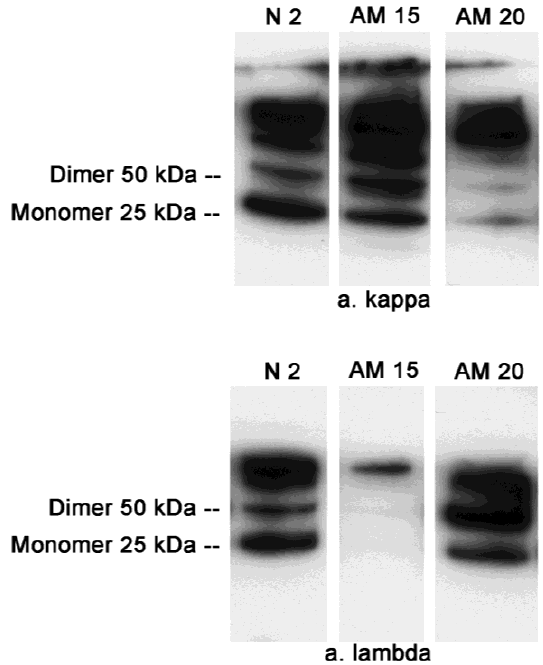
FIGURE 1. Western blot analysis of FLCs in the plasma of a healthy person (N2) and patients with AL-  (AM-15) and AL-  (AM-20) amyloidoses. Plasma samples were run on 20–25% microgels under nonreducing conditions and immunostained using anti-  and anti-  antibodies. Reproduced from Kaplan et